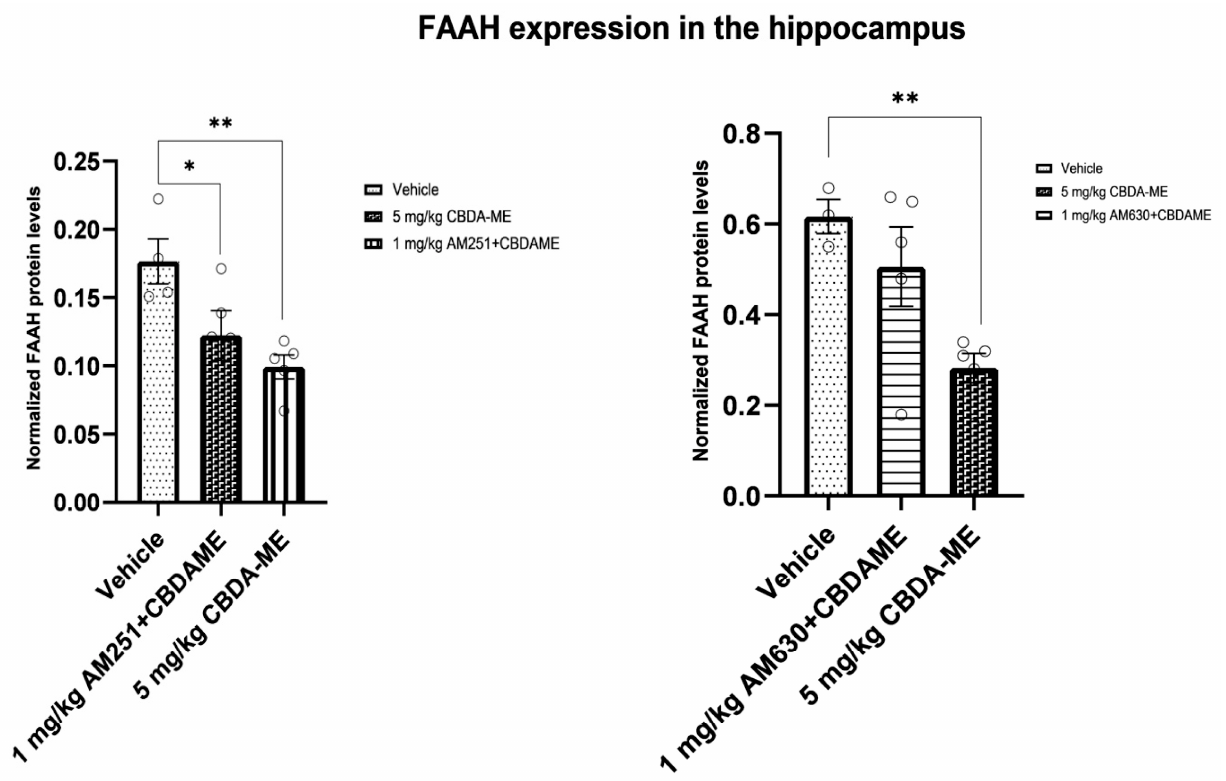
Figure 8. FAAH expression in the hippocampus (mean + SEM) of female WKY rats. Rats received either vehicle (n = 4) or 5 mg/kg CBDA-ME (n = 5), 1 mg/kg AM251 + 5 mg/kg CBDA-ME (n = 5), 1 mg/kg AM630 + 5 mg/kg CBDA-ME (n = 5). * p < 0.05, ** p < 0.01.